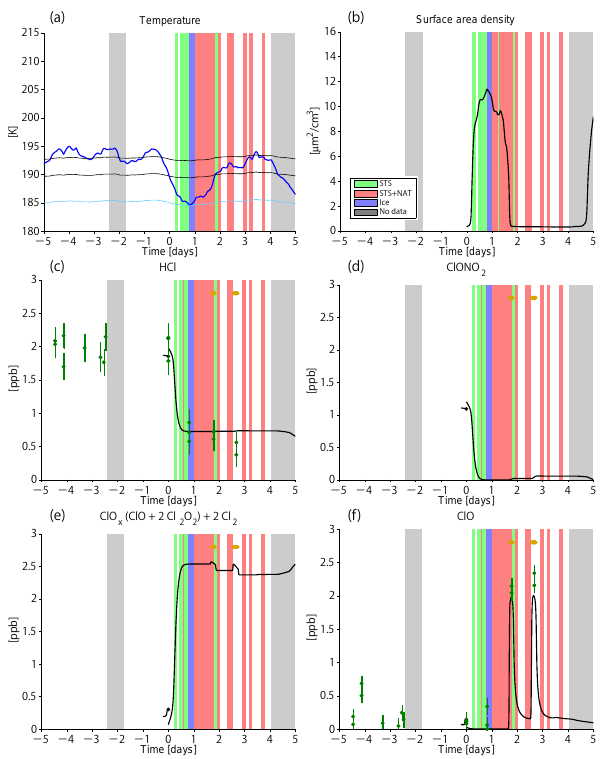
Figure 11. Same as Fig. 8 but for trajectory case no. 02, starting at 08:09:30UT on 21 December 2009 at an altitude of